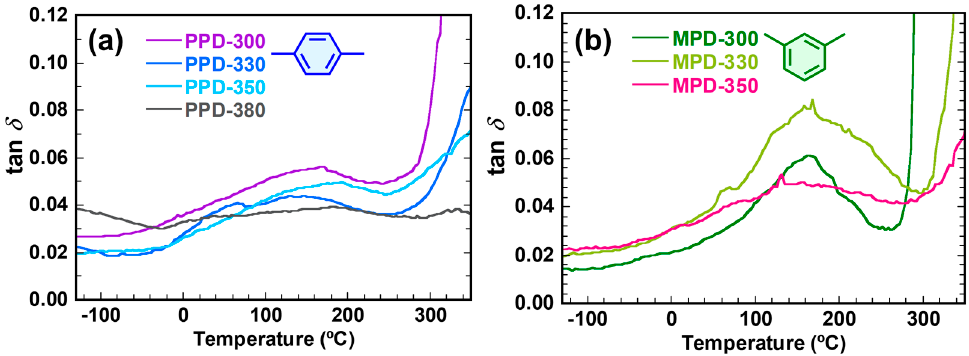
Figure 10. Temperature dependence of tan δ of PI films derived from ( a ) PPD and ( b ) MPD.